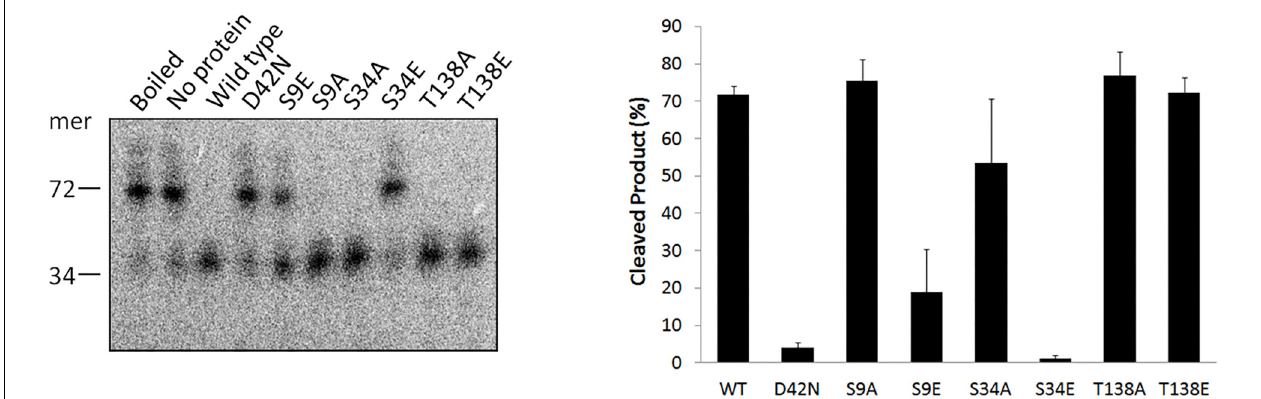
FIGURE 3 | A phosphorylation-mimic Hjc mutant S34E completely lost the HJ DNA cleavage activity. Ten nanomolar wild type Hjc or its mutant was incubated with HJ at 65 ◦ C in 20 µ l reactions (see the Materials and Methods). The samples were mixed with loading buffer, boiled for 10 min, and analyzed on a 15% denatured PAGE gel containing 7 M urea. The position of a 34-nt oligonucleotide ( Supplementary Table S2 ) is indicated at the left side of the gel. The experiments were performed at least for three times. A representative image is shown as the left panel and the quantitation is shown as the right panel. Error bars indicate standard deviation.